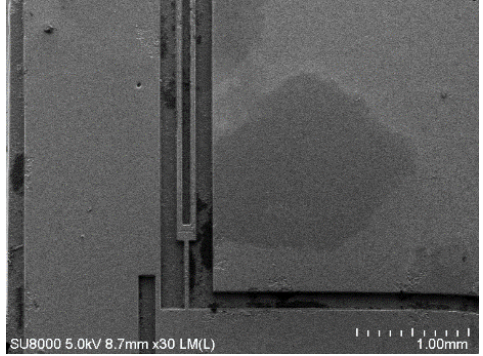
Figure 12. SEM photograph of the top view of the quartz etching structure.